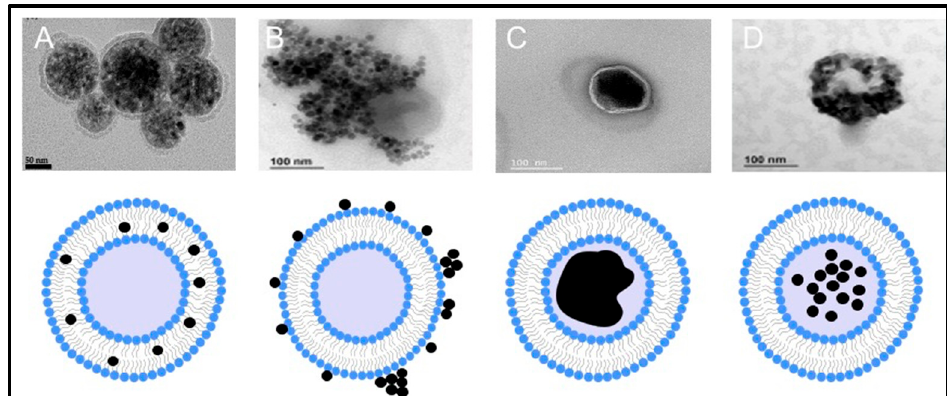
Figure 4. Electron microscopy images (TEM) of the types of magnetoliposomes and schematic representation (not scaled), as examples: ( A ) magnetic nanoparticles within the phospholipid bilayer (partially taken from reference [63], MDPI, Magnetochemistry 2021, 7, 51); ( B ) surface-conjugated nanoparticles (reprinted from reference [9], Copyright © 2020, American Chemical Society, ACS